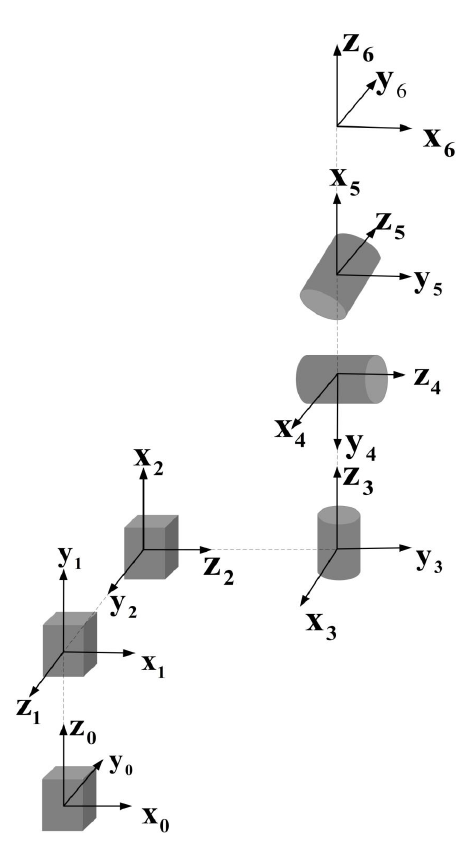
Figure 2. Virtual joints and coordinate frames in an FE